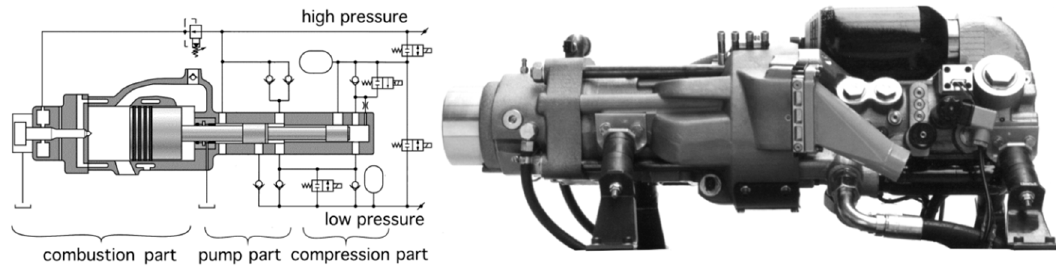
Figure 12. The HFPE prototype of Innas BV. [24].